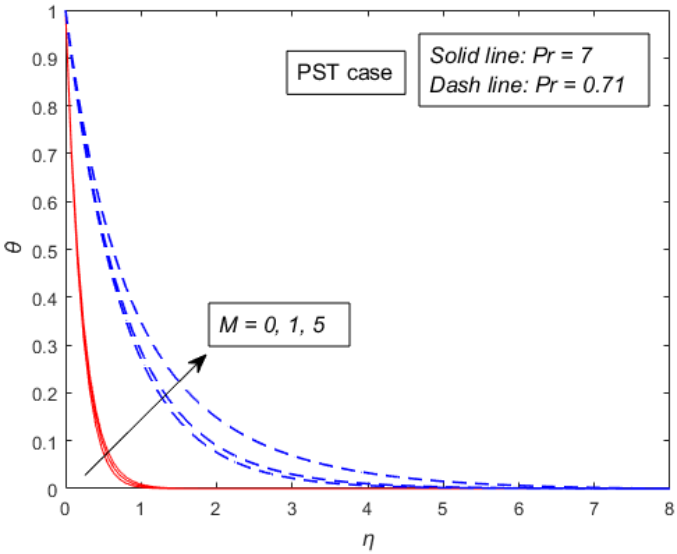
Figure 8. Variation of the temperature profile for different values of magnetic parameter M and Prandtl number Pr for the PST case when n = 3, K = 1, and Ec =